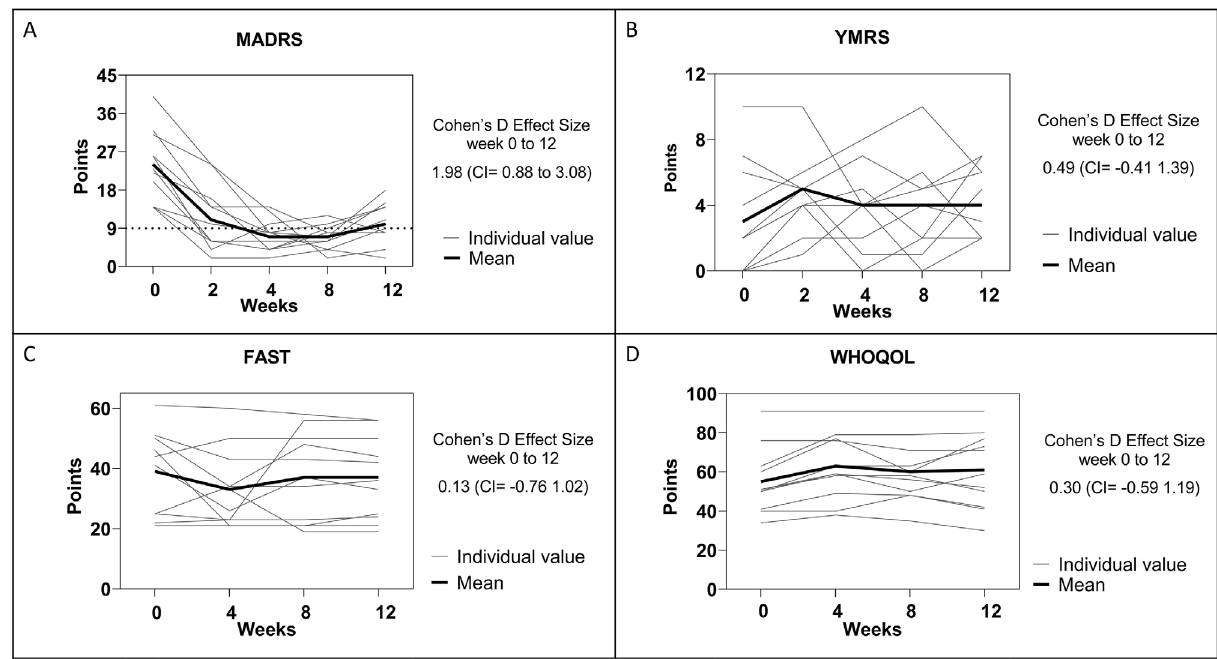
Fig. 1 Results for depressive symptoms, manic symptoms, functioning and quality of life (Individual and mean value). Panel A = MADRS (Montgomery- Asberg Depression Scale); Panel B = YMRS (Young Mania Rating Scale); Panel C = FAST (Functioning Assessment Short Test); Panel D = WHOQOL (World Health Organization Quality of Life). 9-point line in panel A = remission. Change between baseline and 2, 4, 8, and 12 weeks and the Cohen’s d effect